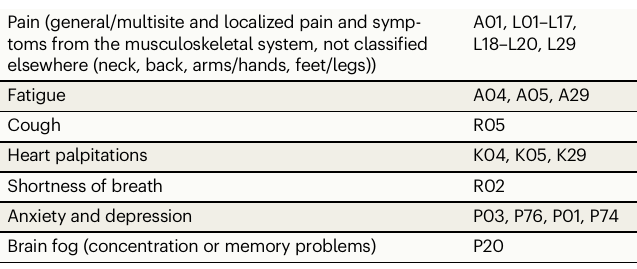
Table 3 | Condition/complaint with corresponding diagnostic code (ICPC-2) used in primary care a Pain (general/multisite and localized pain and symp- toms from the musculoskeletal system, not classi fi ed elsewhere (neck, back, arms/hands,